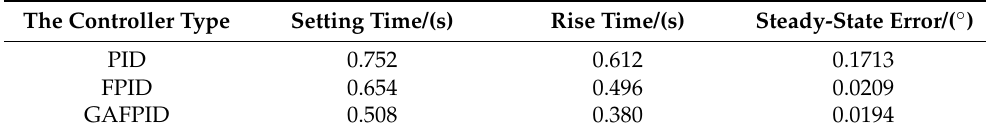
Table 4. Simulation results of the step response.